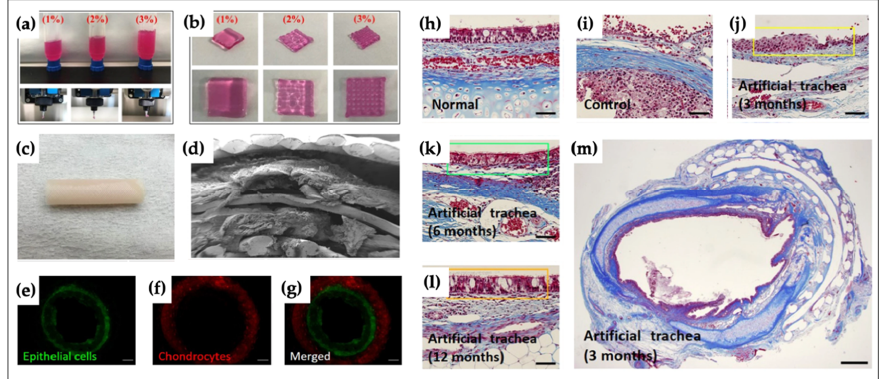
Figure 6. Characteristics of biofabricated artificial tracheal structure and histopathologic results of epithelial formation [174]. ( a ) 1, 3 and 5% alginate hydrogel being extruded through the ceramic